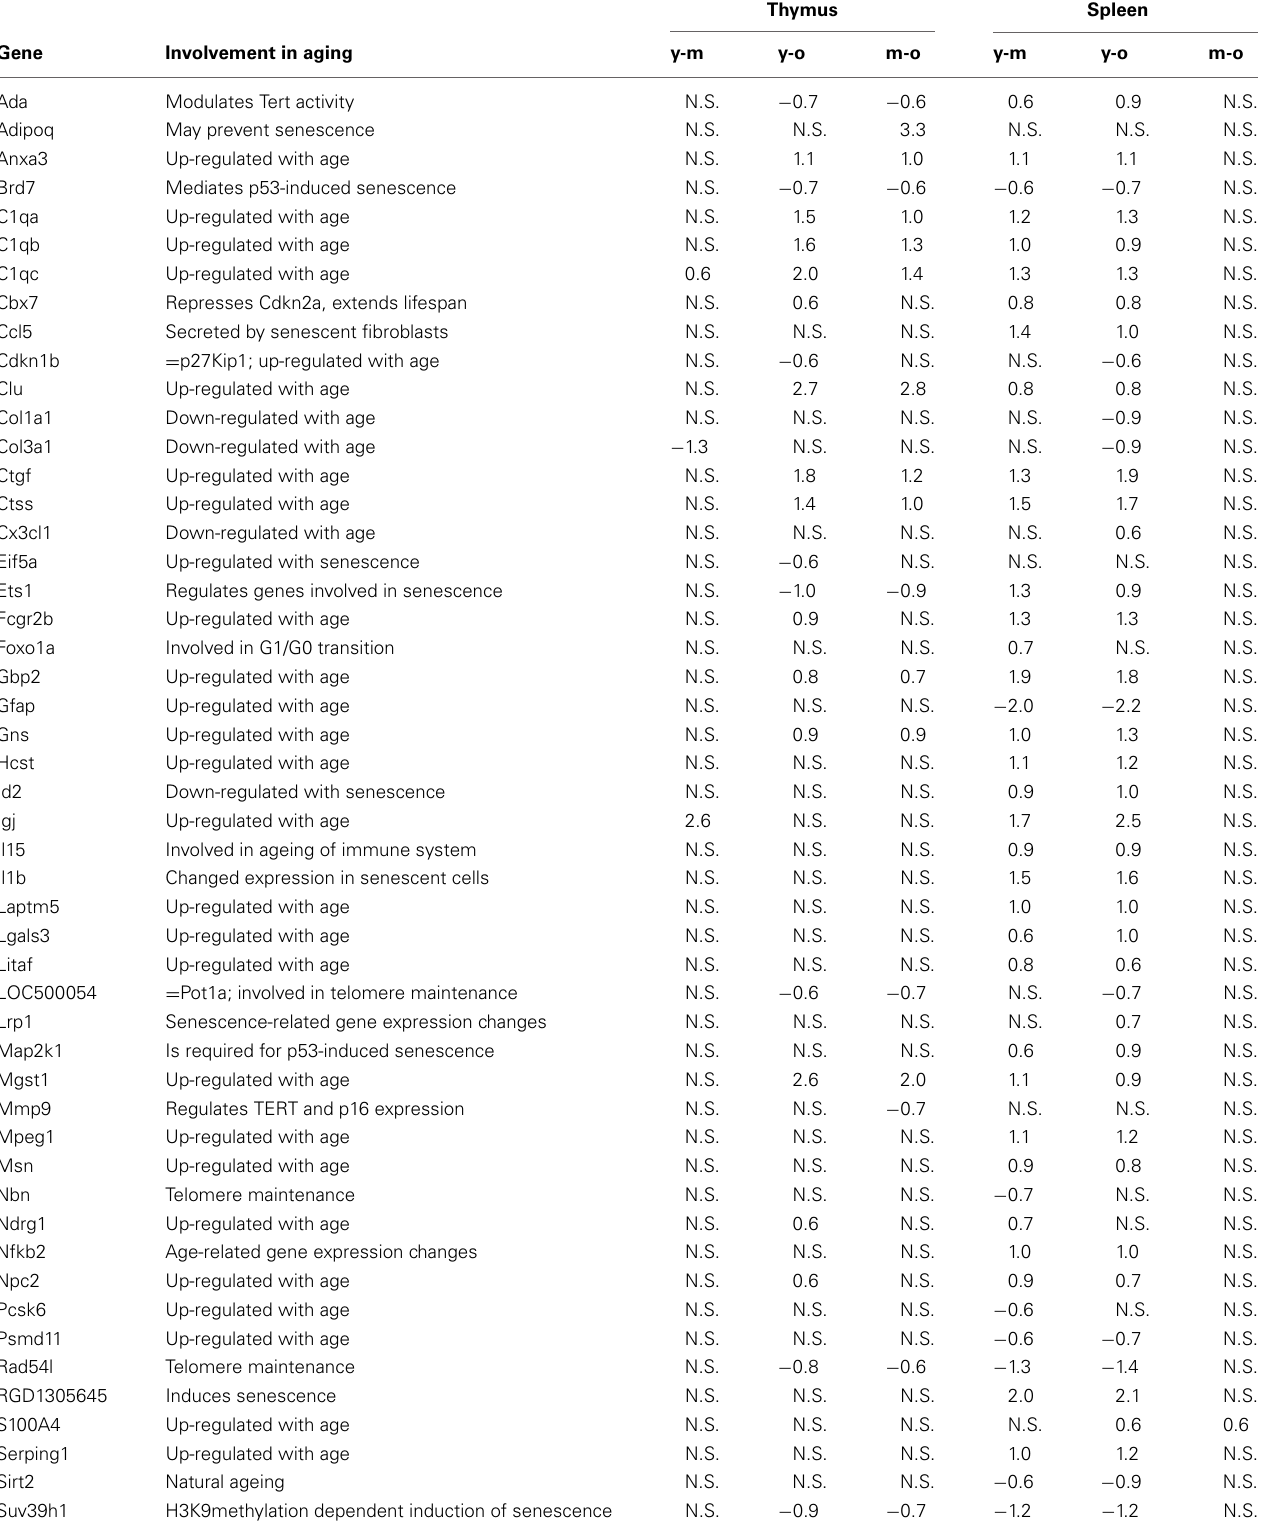
Table 2 | Senescence-associated gene